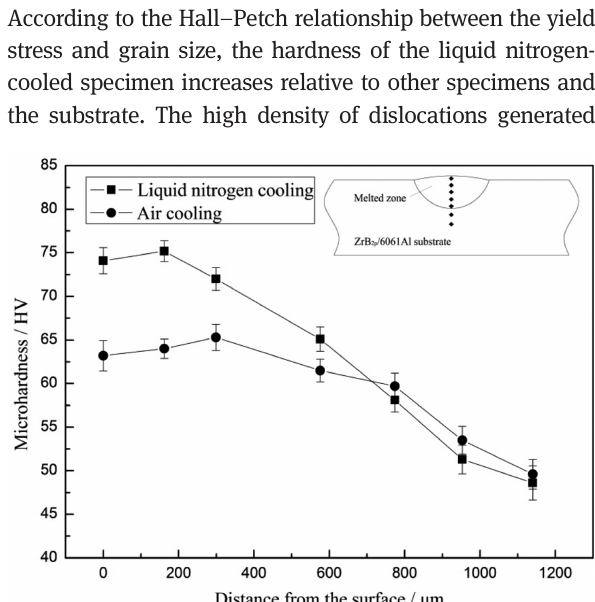
Figure 10: Microhardness of the laser-melted